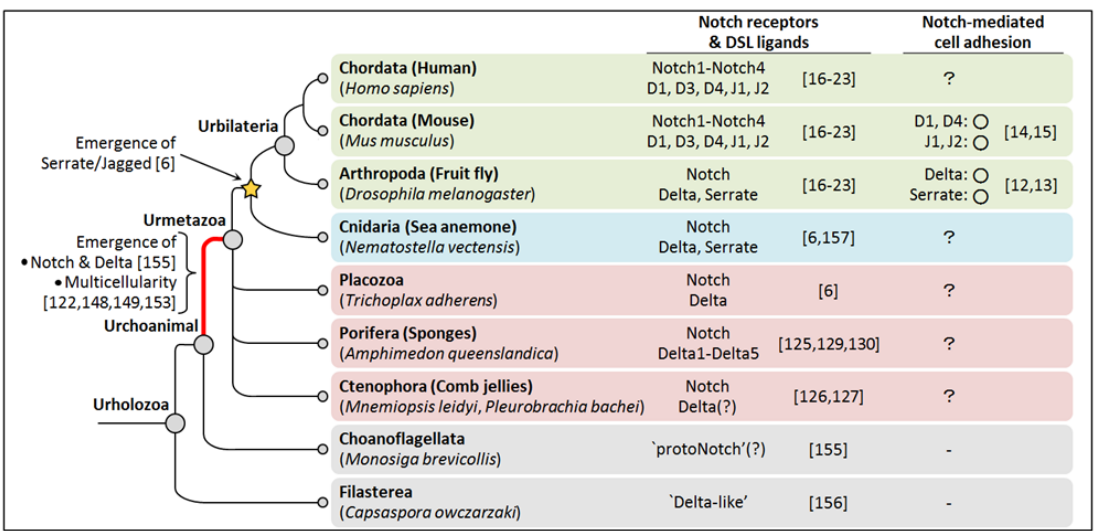
Figure 5. A summary of Notch-mediated cell adhesion in organisms described in this review. The simplified phylogenic tree is depicted based on reference [152]. The last common ancestors of each group are indicated as filled circles at nodes. Branches are collapsed at the base of Metazoa to reflect current uncertainty about the branch order of the most basal metazoan phyla [152]. In Ctenophora, P. bachei has the orthologue of Delta [127], while M. leidyi has no diagnostic domains for Delta [126]. In the column for Notch-mediated cell adhesion, the existence of the cell adhesion function in Notch family members is shown as open circles. D, Delta-like; J, Jagged.